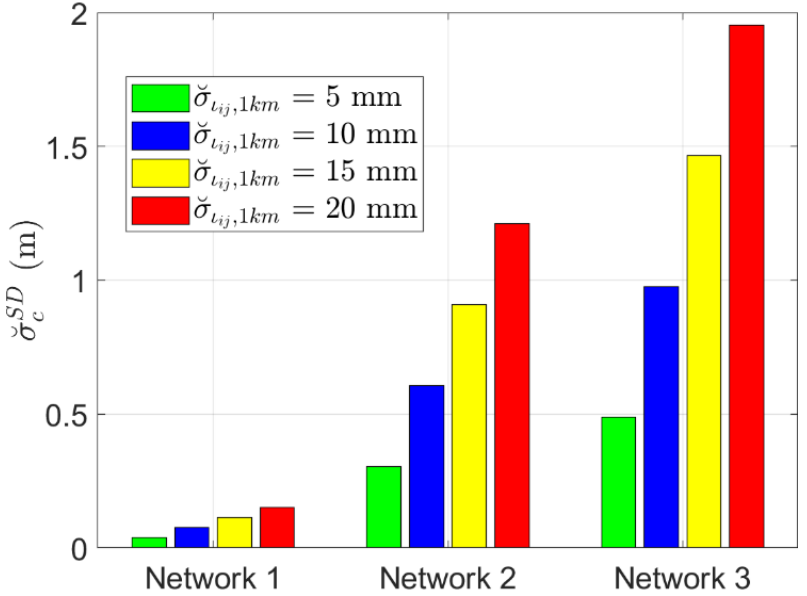
Figure 10. HPLs of different PMI H under different multipath/ionosphere conditions in: ( a ) the ambiguity-float case; ( b ) the ambiguity-fixed case. The solid, dashed, dashed-dotted and dotted lines represent the PMI H of 2 × 10 − 3 , 2 × 10 − 4 , 2 × 10 − 5 and 2 × 10 − 6 , respectively.